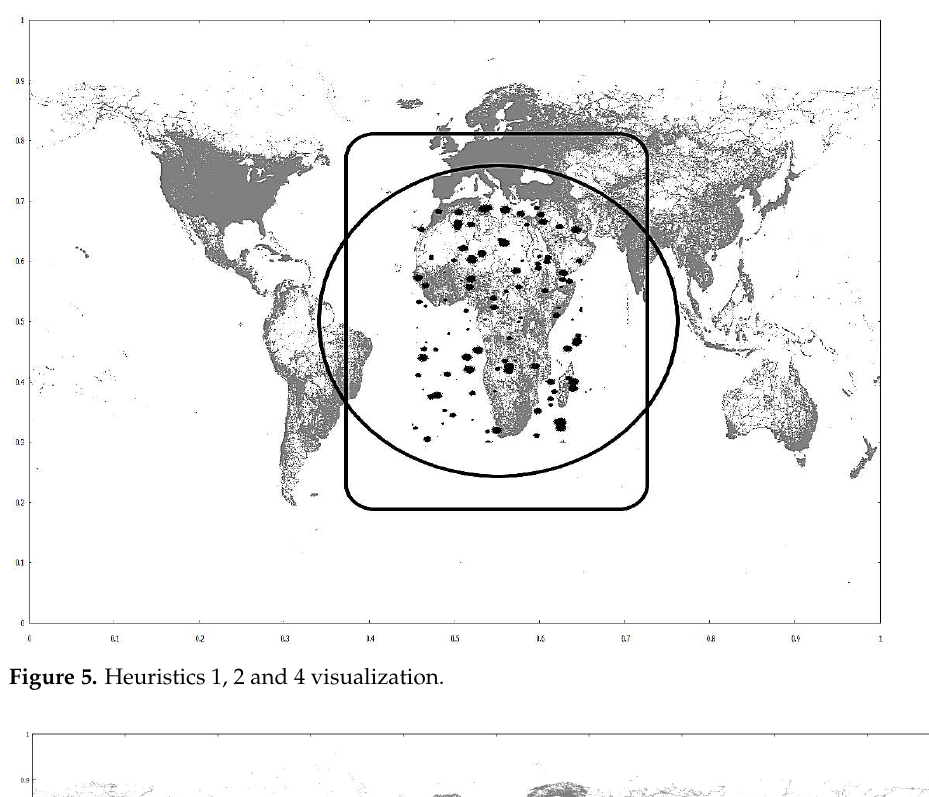
Figure 5. Heuristics 1, 2 and 4 visualization.